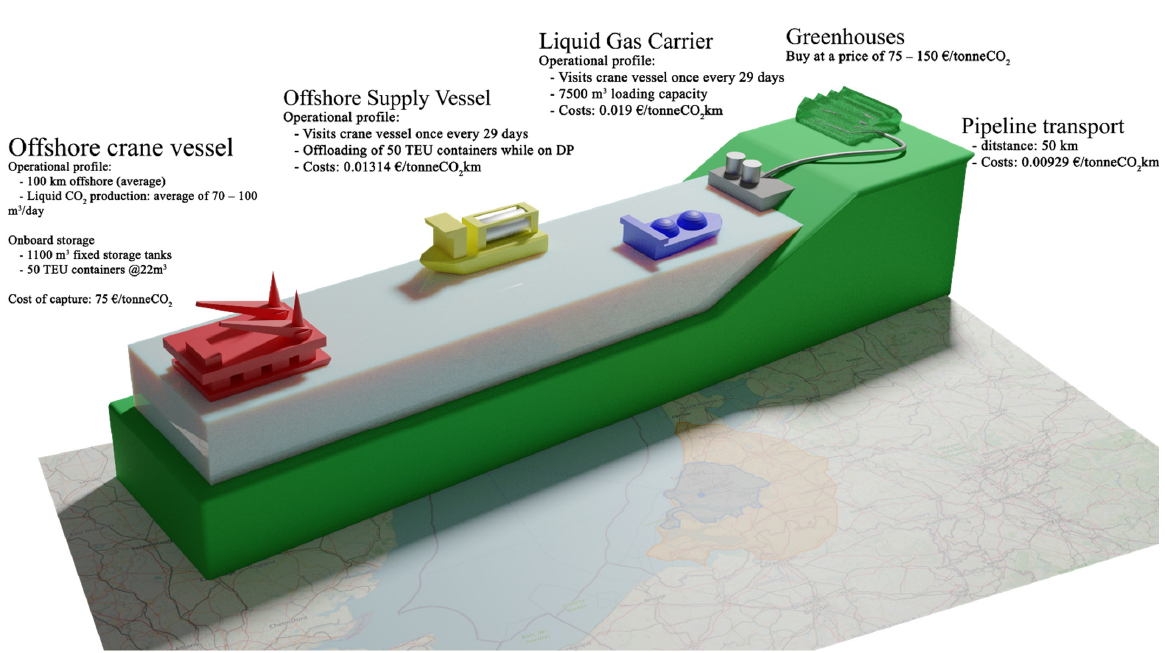
Figure 6. Visualization of supply chain from case study (own